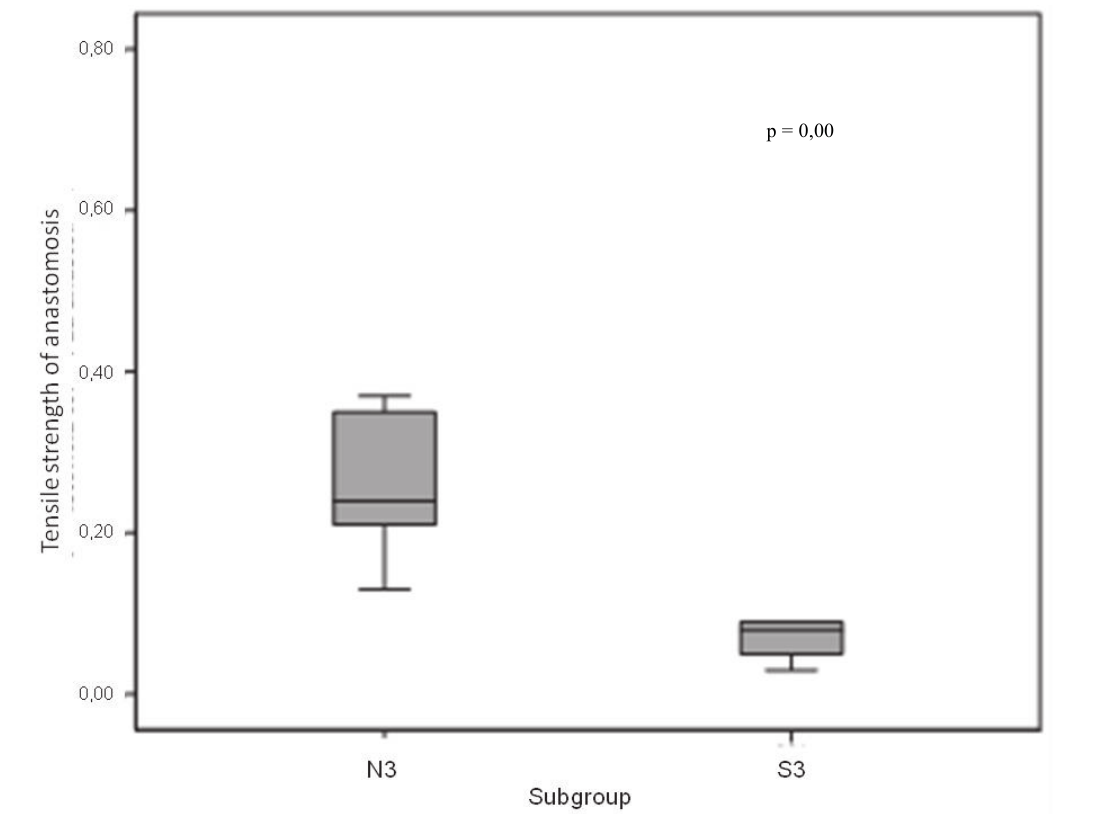
FIGURE 2 - Median and interval values for bursting strength in the anastomosis of subjects which underwent euthanasia on the third post-operatory